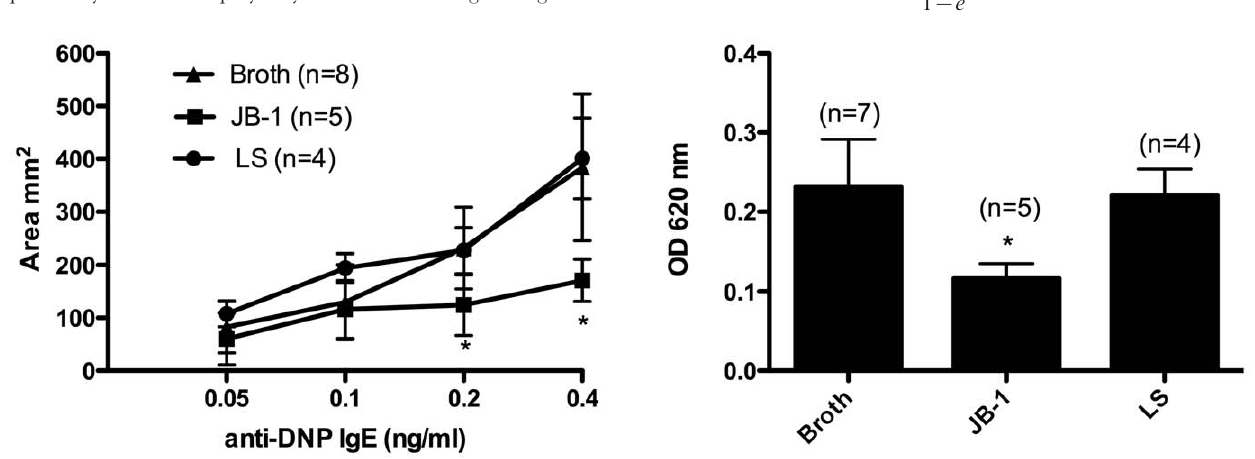
Figure 4. The passive cutaneous reaction induced by DNP-HSA following sensitization with anti-DNP IgE in rats treated orally with MRS broth (broth), L.rhamnosus (JB-1) or L.salivarius (LS) as assessed by the reaction area (A) and the amount of dye extracted from the back skin (B). Data is presented as mean 6 SD, 3 independent experiments were performed with number of animals in each treatment group as indicated, *=p , 0.05.